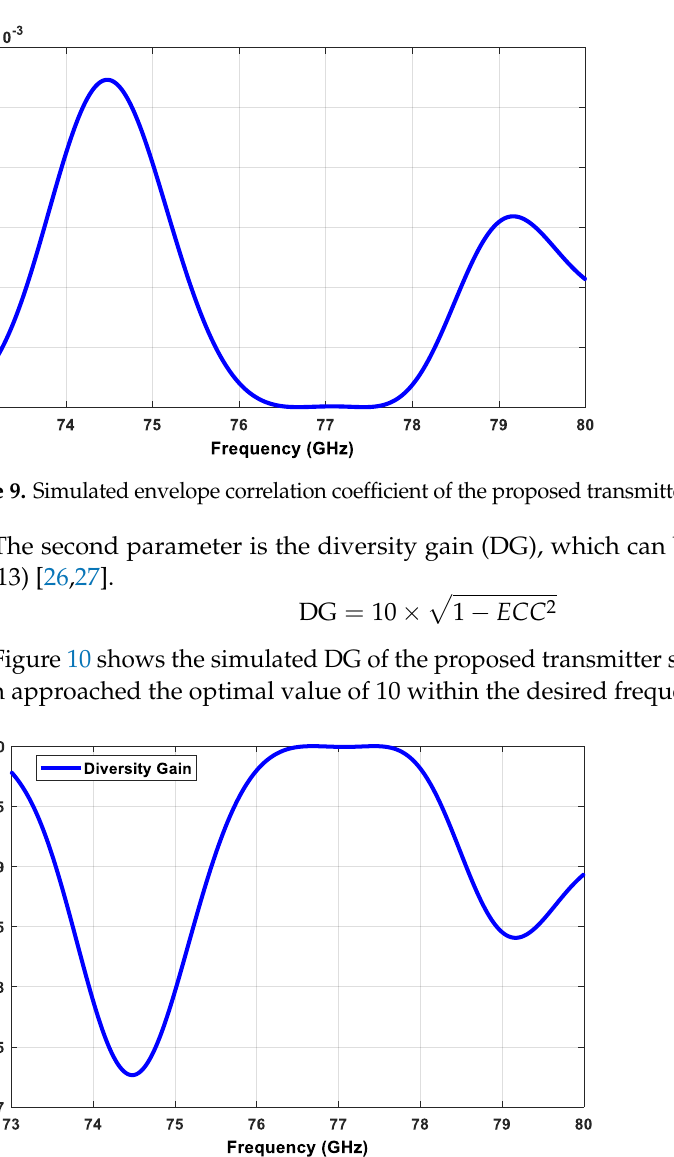
Figure 10. Simulated DG of the proposed transmitter subarray configuration .